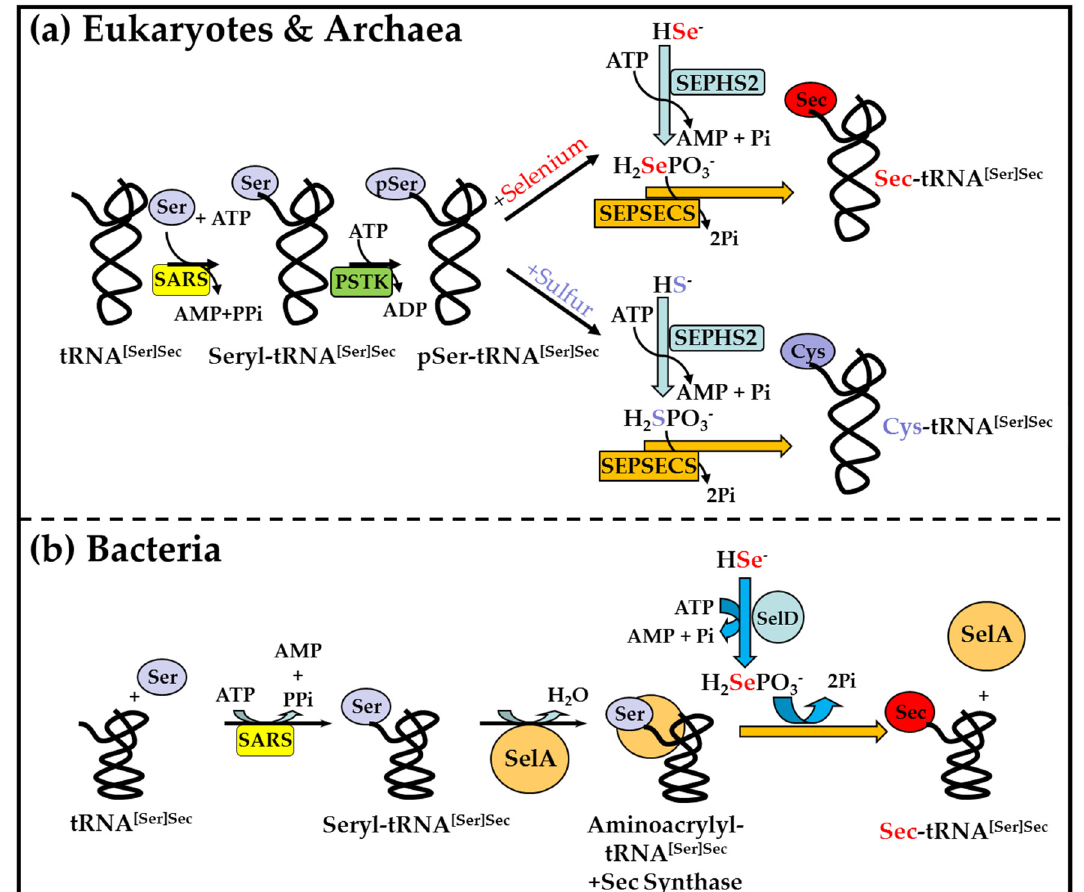
Figure 2. Pathways of Selenocysteine (Sec) biosynthesis. The biosynthetic pathways of Sec in: ( a ) eukaryotes and archaea; ( b ) bacteria. Abbreviations are: Pi—inorganic phosphate; PPi—inorganic pyrophosphate; SARS—Ser-tRNA synthetase; SelA—selenocysteine synthase; SelD—selenophosphate synthetase; H 2 SePO 3 − —selenophosphate; SEPHS2—selenophosphate synthetase